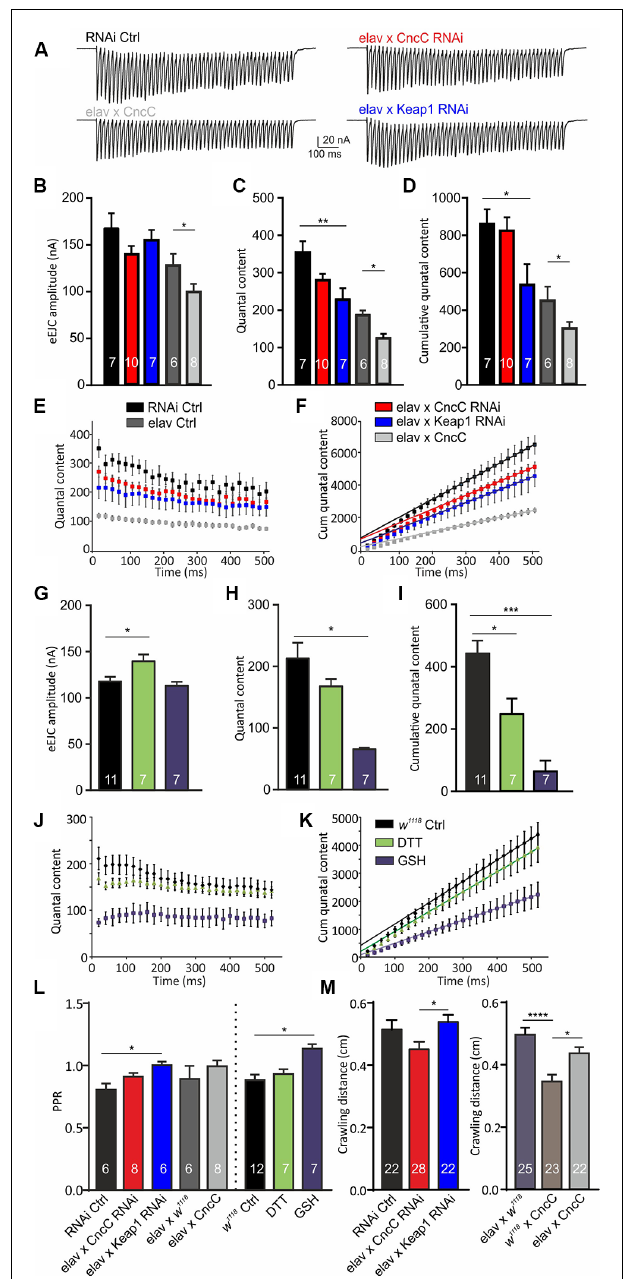
FIGURE 3 | Increased antioxidant environment allows for reduction of stimulated vesicular release while maintaining synaptic transmission. (A) Recordings of evoked synaptic currents at the larval NMJ. Graphs show means for evoked EJC (eEJC) amplitudes (B) , quantal content (QC; C ) and cumulative QC (D) , QC and cumulative QC graphs of 50 Hz trains for genotypes indicated (E,F) . eEJC amplitudes (G) , QC (H) and cumulative QC (I) for treatments indicated. (J,K) Graphs of 50 Hz trains from w 1118 larvae and w 1118 larvae treated with GSH and DTT. (L) Paired-pulse ratios (PPR) were analyzed at 20 ms inter-spike intervals at NMJs from indicated genotypes and/or treatments [ANOVA used for comparison of RNAi expressing strains, Student’s t -test was used to compare elav × CncC with elav Ctrl, n —number of NMJs (from at least three larvae) indicated within